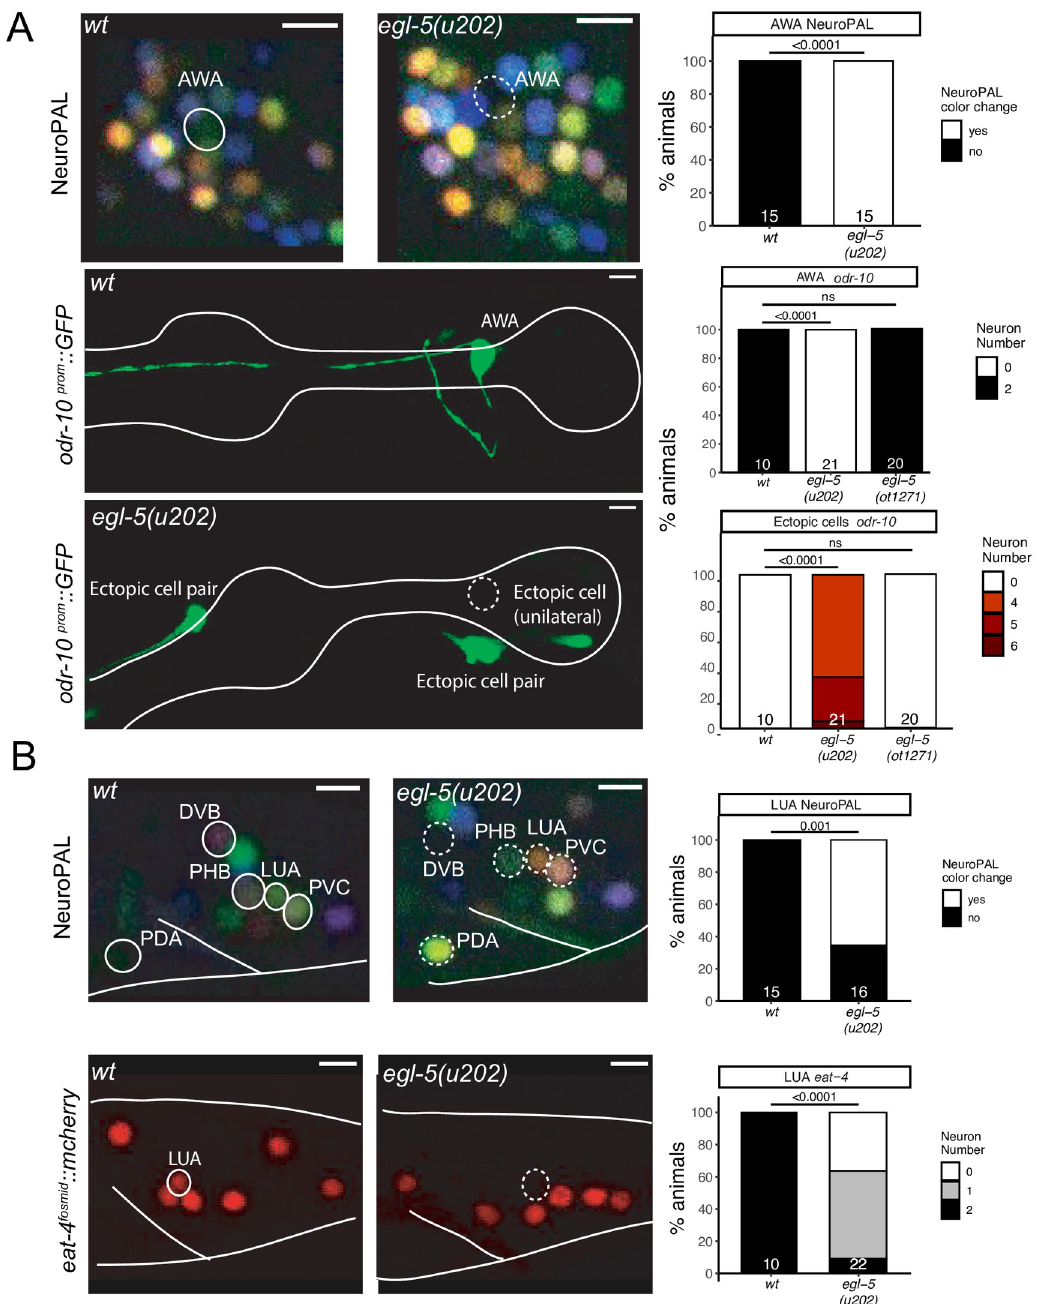
Fig 8. The HOX gene egl-5 affects the differentiation of head and tail neurons. Fig 8A: egl-5(u202) mutant animals show a loss of AWA marker expression, including NeuroPAL ( otIs669 ) and an odr-10 reporter transgene ( kyIs37 ). Representative images of wildtype and mutant worms are shown with 5 μ m scale bars. Graphs compare expression in wildtype and mutant worms with the number of animals examined listed at the bottom of the bar. P-values were calculated by Fisher’s exact test. Fig 8B: egl-5(u202) mutant animals show changes in tail marker expression, including NeuroPAL ( otIs669 ) in PDA, LUA, PVC and loss of eat-4 ( otIs518 ) expression in LUA. Representative images of wildtype and mutant worms are shown with 5 μ m scale bars. Graphs compare expression in wildtype and mutant worms with the number of animals examined listed at the bottom of the bar. P-values were calculated by Fisher’s exact test. In all panels, neurons of interest are outlined in solid white when expressing wildtype reporter colors, and dashed white when one or all colors are